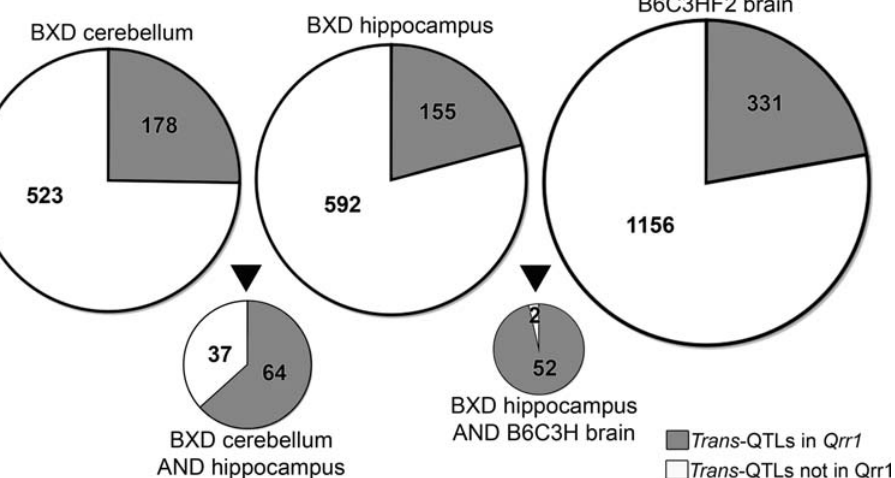
Figure 1. Highly replicable trans-QTLs in Qrr1 . The charts illustrate the total number of trans -QTLs (LOD $ 4) in Qrr1 (shaded) and in other regions of the genome (non-shaded) in three datasets—BXD cerebellum, BXD hippocampus, and B6C3H F2 brain. The smaller charts represent the trans -QTLs in BXD hippocampus that are also detected in BXD cerebellum, and B6C3HF2 brain datasets. Out of the 101 trans -QTLs common to both BXD hippocampus and cerebellum, 64 are in Qrr1 and the remaining 37 are located in other regions of the genome. The BXD hippocampus and B6C3HF2 brain datasets have 54 common trans -QTLs, and almost all (52 out of 54) are in Qrr1 . doi:10.1371/journal.pgen.1000260.g001 PLoS Genetics |